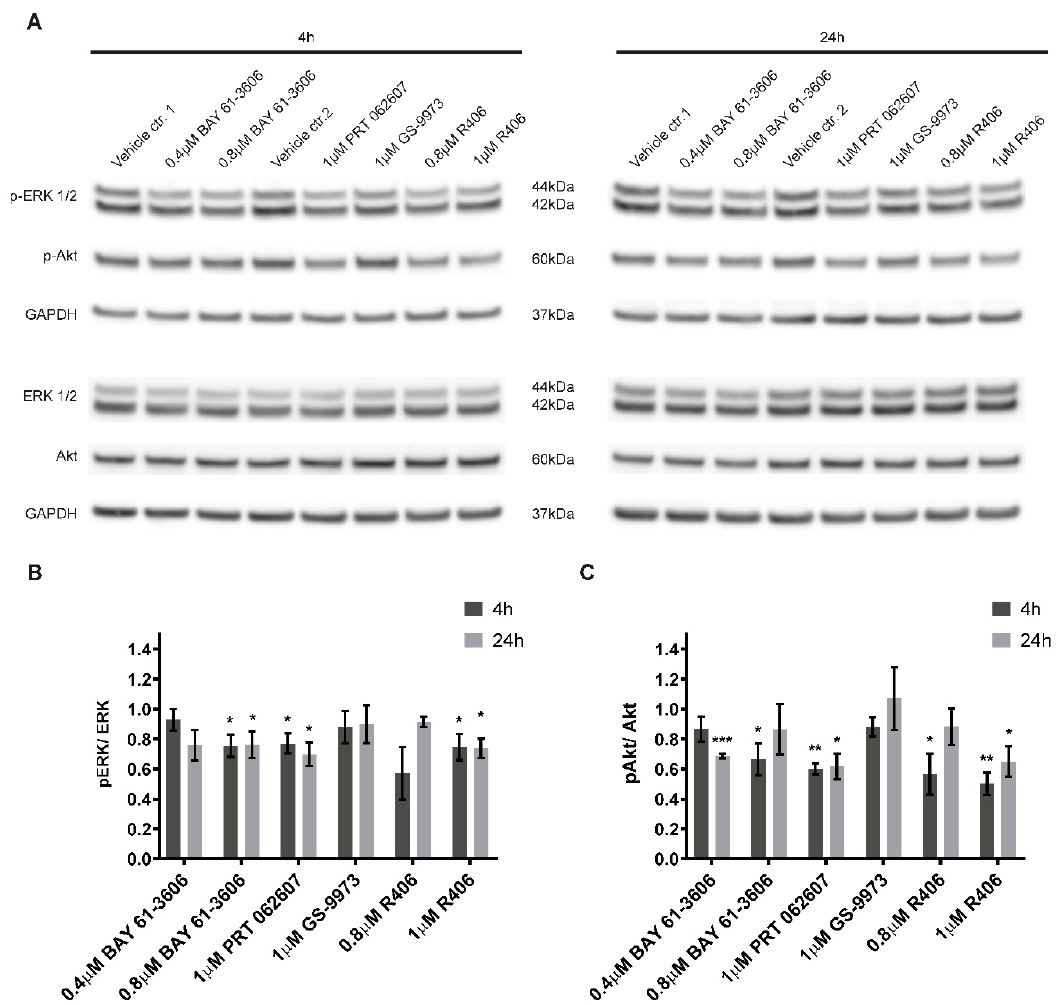
Figure 6. SYK inhibition decreases ERK1/2 and Akt phosphorylation. SYK inhibitors BAY 61-3606, R406, and PRT062607 reduce the phosphorylation of ERK1/2 and Akt in SH-SY5Y cells after a 4 or 24 h treatment ( A ). Control cells were treated with the corresponding vehicles (water = vehicle control 1 and DMSO = vehicle control 2). Densitometric analysis of the protein bands was performed. Phosphorylated and total protein were normalized to their respective GAPDH loading controls and the ratios between normalized p-ERK1/2 and ERK as well as normalized p-Akt and Akt were calculated. The values are displayed as mean ± SD relative to the vehicle control = 1 ( B and C ). The results are based on three independent experiments. One sample t-test (two-tailed) was performed to compare the vehicle (theoretical mean = 1) vs. inhibitor treatment: * p < 0.05 ** p < 0.01 *** p < 0.001.